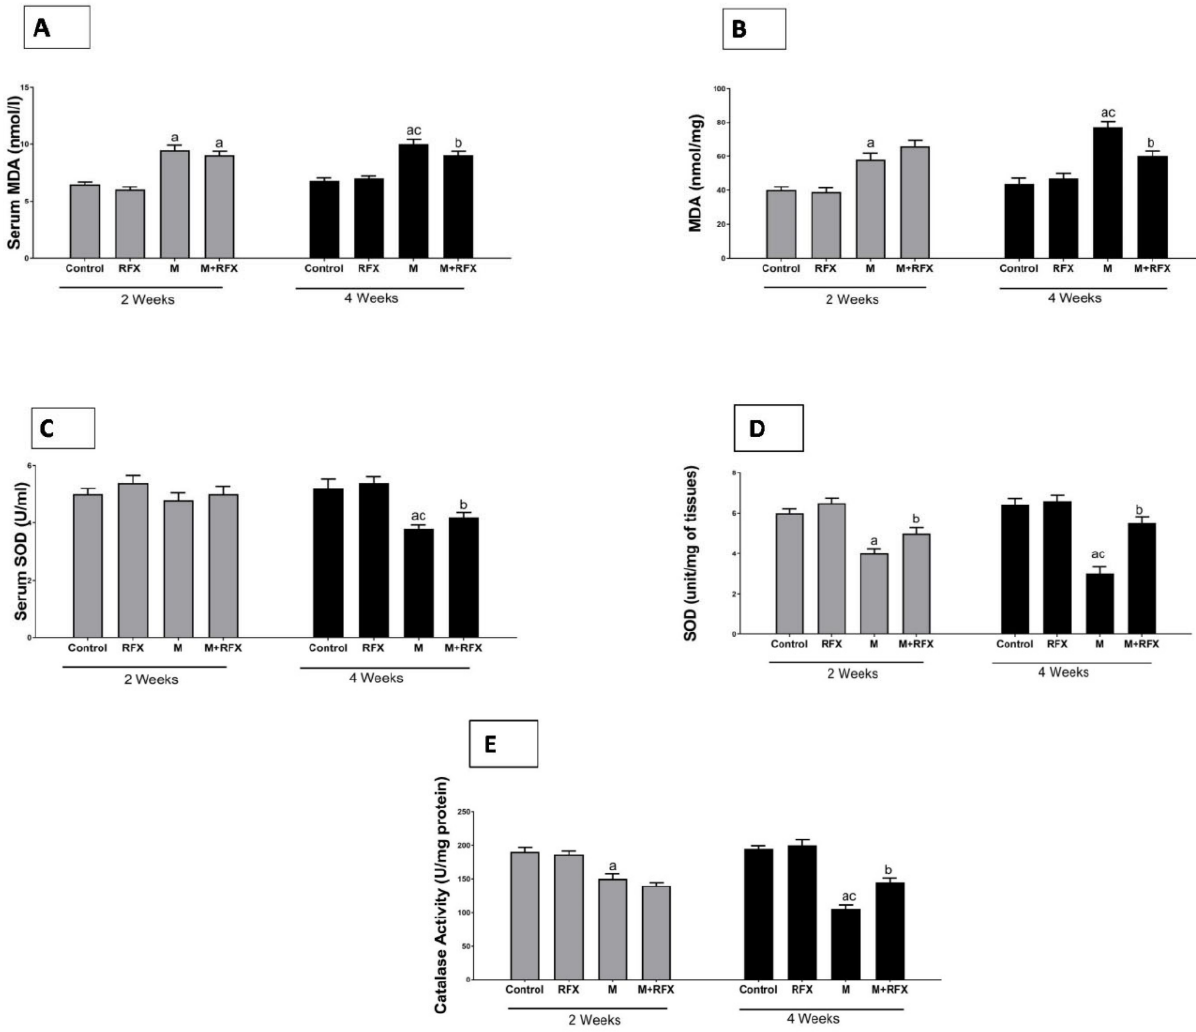
Figure 10. Effects of RFX administration on serum and testicular oxidative stress markers in rats exposed to malathion for four weeks. ( A ): Serum MDA (nmoles/L) after 2 and 4 weeks in different groups. ( B ): Testicular MDA (nmoles per mg tissue) after 2 and 4 weeks in different groups. ( C ): Serum SOD (unit/mL) after 2 and 4 weeks in different groups. ( D ): Testicular SOD (unit/mg of tissues) after 2 and 4 weeks in different groups. ( E ): Testicular catalase (unit/mg protein) after 2 and 4 weeks in different groups. Data are presented as the means ± SEM. a, significant ( p < 0.05) versus control; b, significant ( p < 0.05) versus the malathion group; c, significant ( p < 0.05) versus the two weeks group; data were analyzed with one-way ANOVA, followed by Bonferroni-corrected post hoc tests. RFX, rifaximin; M, malathion; M + RFX, malathion and rifaximin.